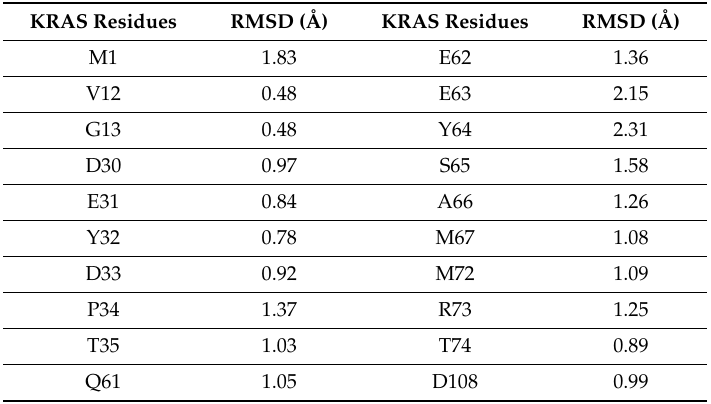
Root mean square deviation (RMSD) values between KRAS G12V and KRAS G12V-H-REV107